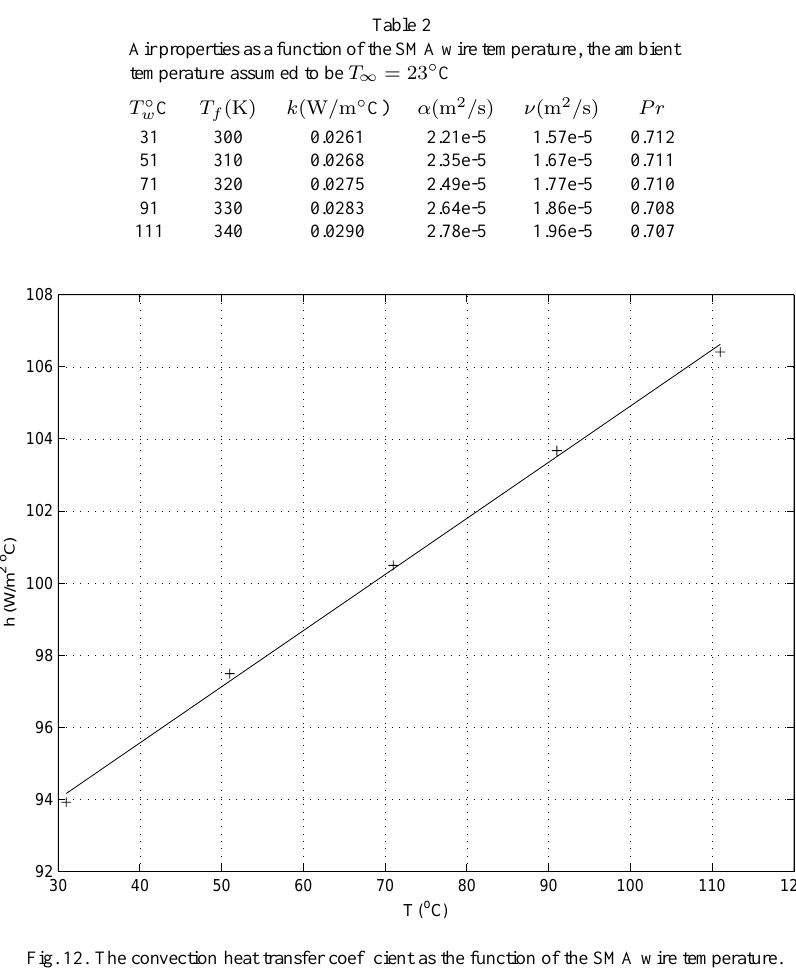
Table 2 Airproperties asafunction of the SMAwire temperature, the ambient